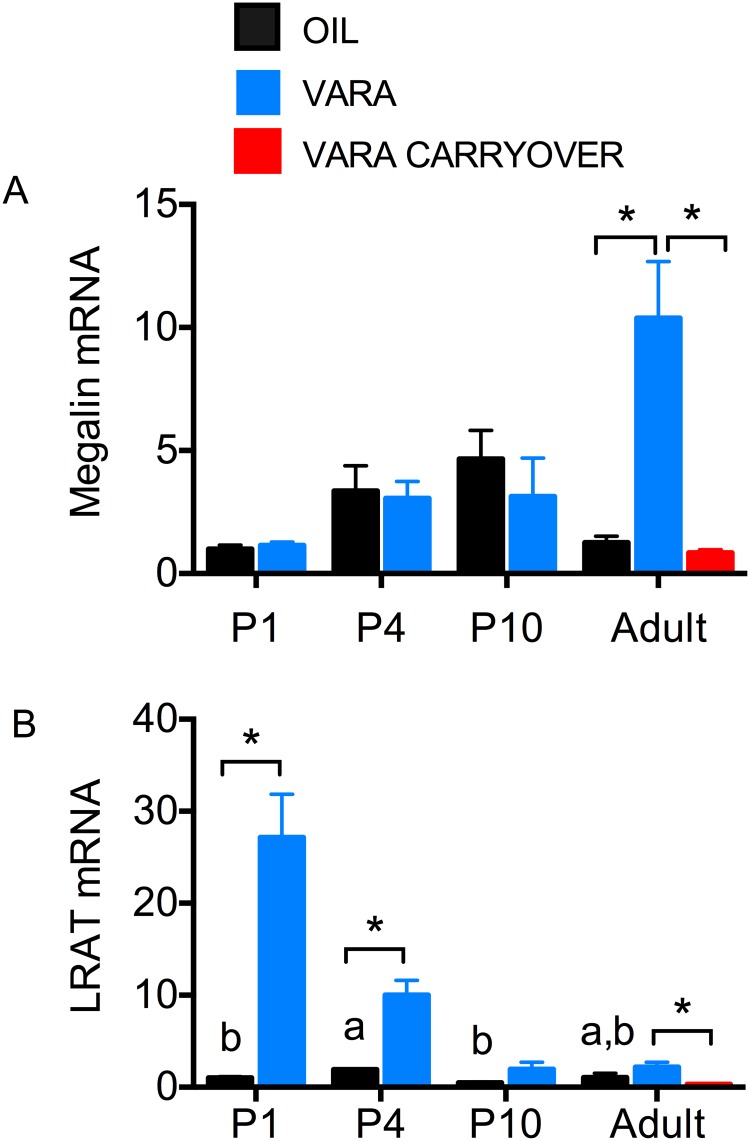
Expression of megalin and Lrat in kidney of neonatal rats and adult-age rats fed VAM diet and treated with or without VARA.Relative levels of mRNA transcripts are shown for megalin (A) and Lrat (B) in kidney. under experimental conditions described in Fig 1A. Asterisks (*) denote differences between oil and VARA groups in adult kidney, P < 0.05. Data are mean ± SEM, n ≥ 7/group. Abbreviations: P, postnatal day; VARA, vitamin A combined with 10% retinoic acid.